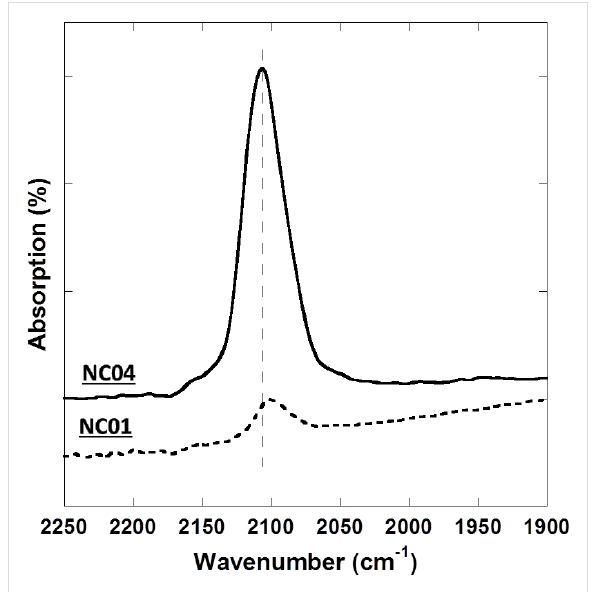
Figure 11: IR spectra of NC01 and NC04